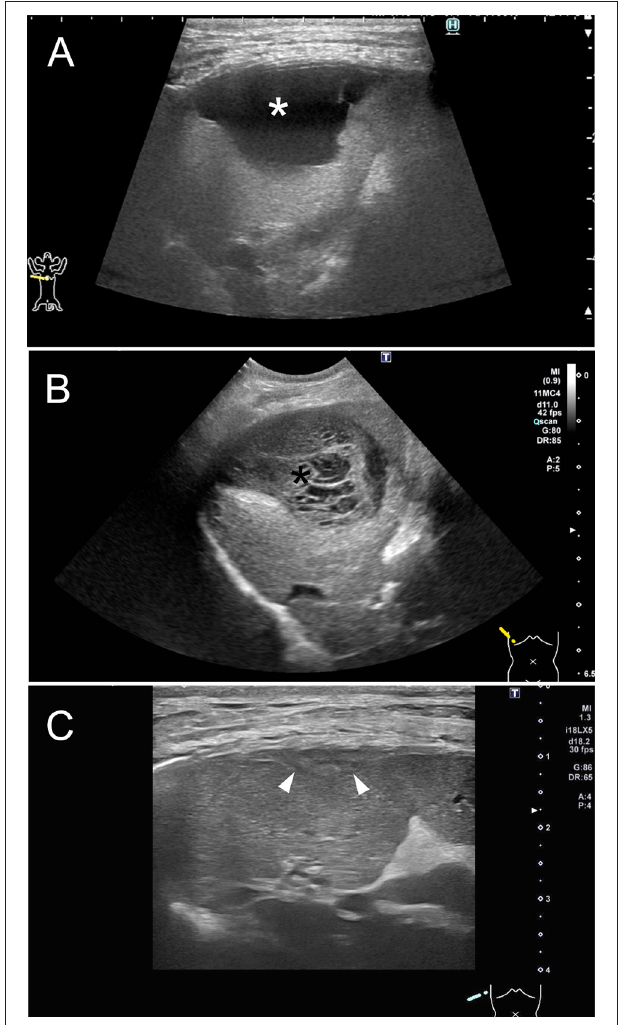
FIGURE 3 | Ultrasonography of the right liver lobes through a right intercostal approach from three different time points. (A) On initial presentation, well-defined anechoic localized fluid accumulation was detected around the right liver lobes. (B) On day 6, ultrasonography revealed that the size of biloma was stable, but its appearance had changed, showing a decreased fluid and organized echoic non-mobile collections, such as mucocele (black asterisk). (C) On postoperative day 10, abdominal ultrasonography was able to detect a trace level of biloma wall (white arrow-head) but no fluid accumulation around the right hepatic